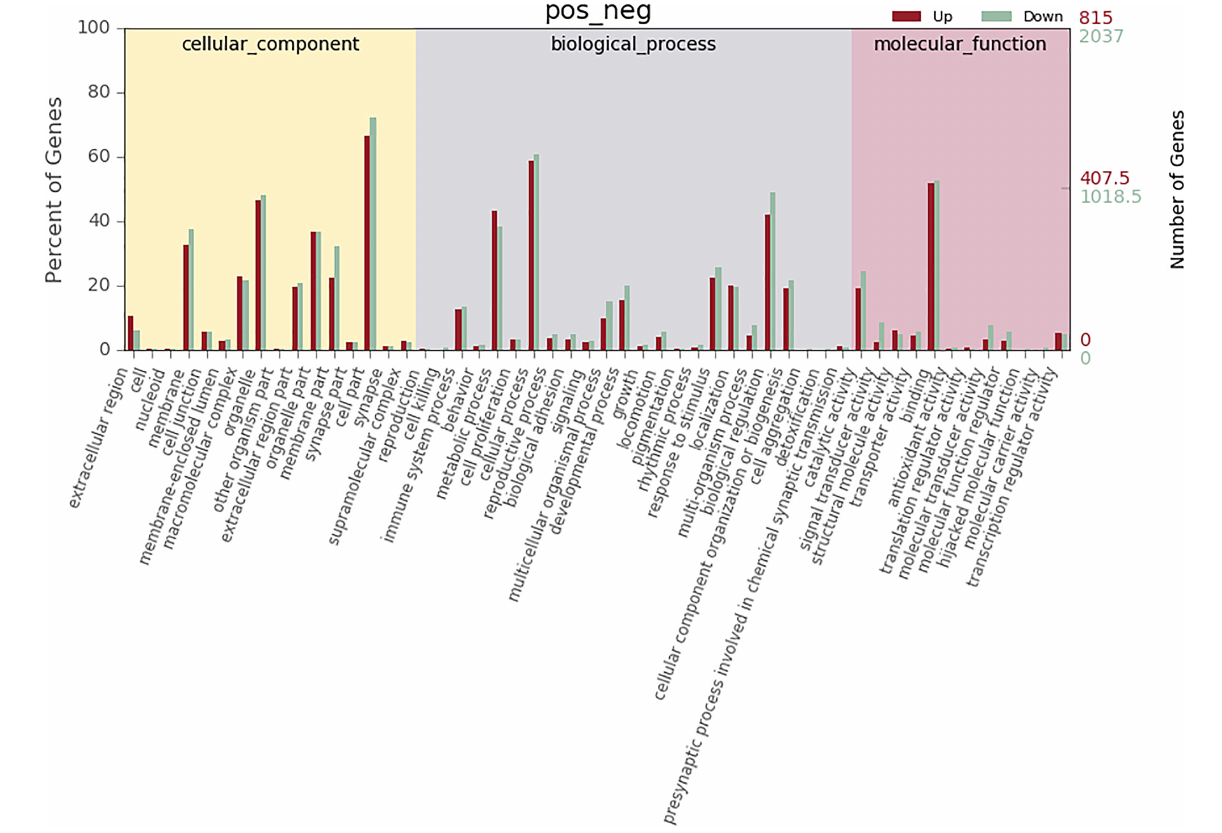
FIGURE 7 | GO analysis of lncRNA in MM. The significant molecular function, biological process, and cellular component changed mRNA-targeted ncRNAs in MM. Statistics of DE gene annotation results in GO entries. The abscissa is the second-level GO entry in the DE gene annotation results, the left ordinate is the proportion of upregulated/downregulated DE genes, and the right ordinate is the number of upregulated/downregulated DE